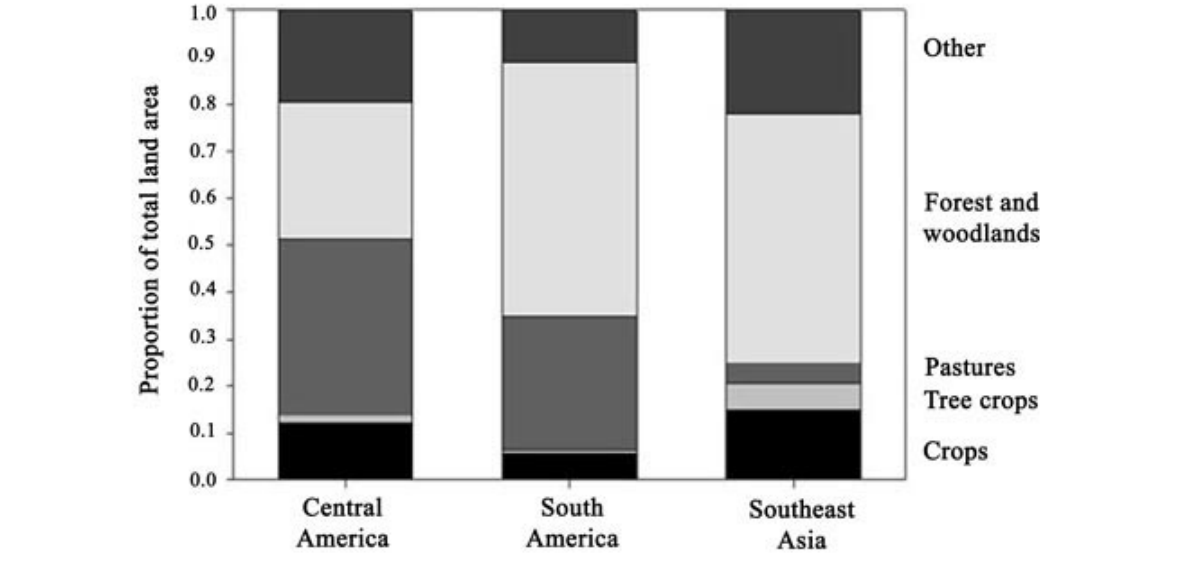
Fig. 2. Proportion of land covered by different land uses in Central and South America, and Southeast Asia. Source: FAO